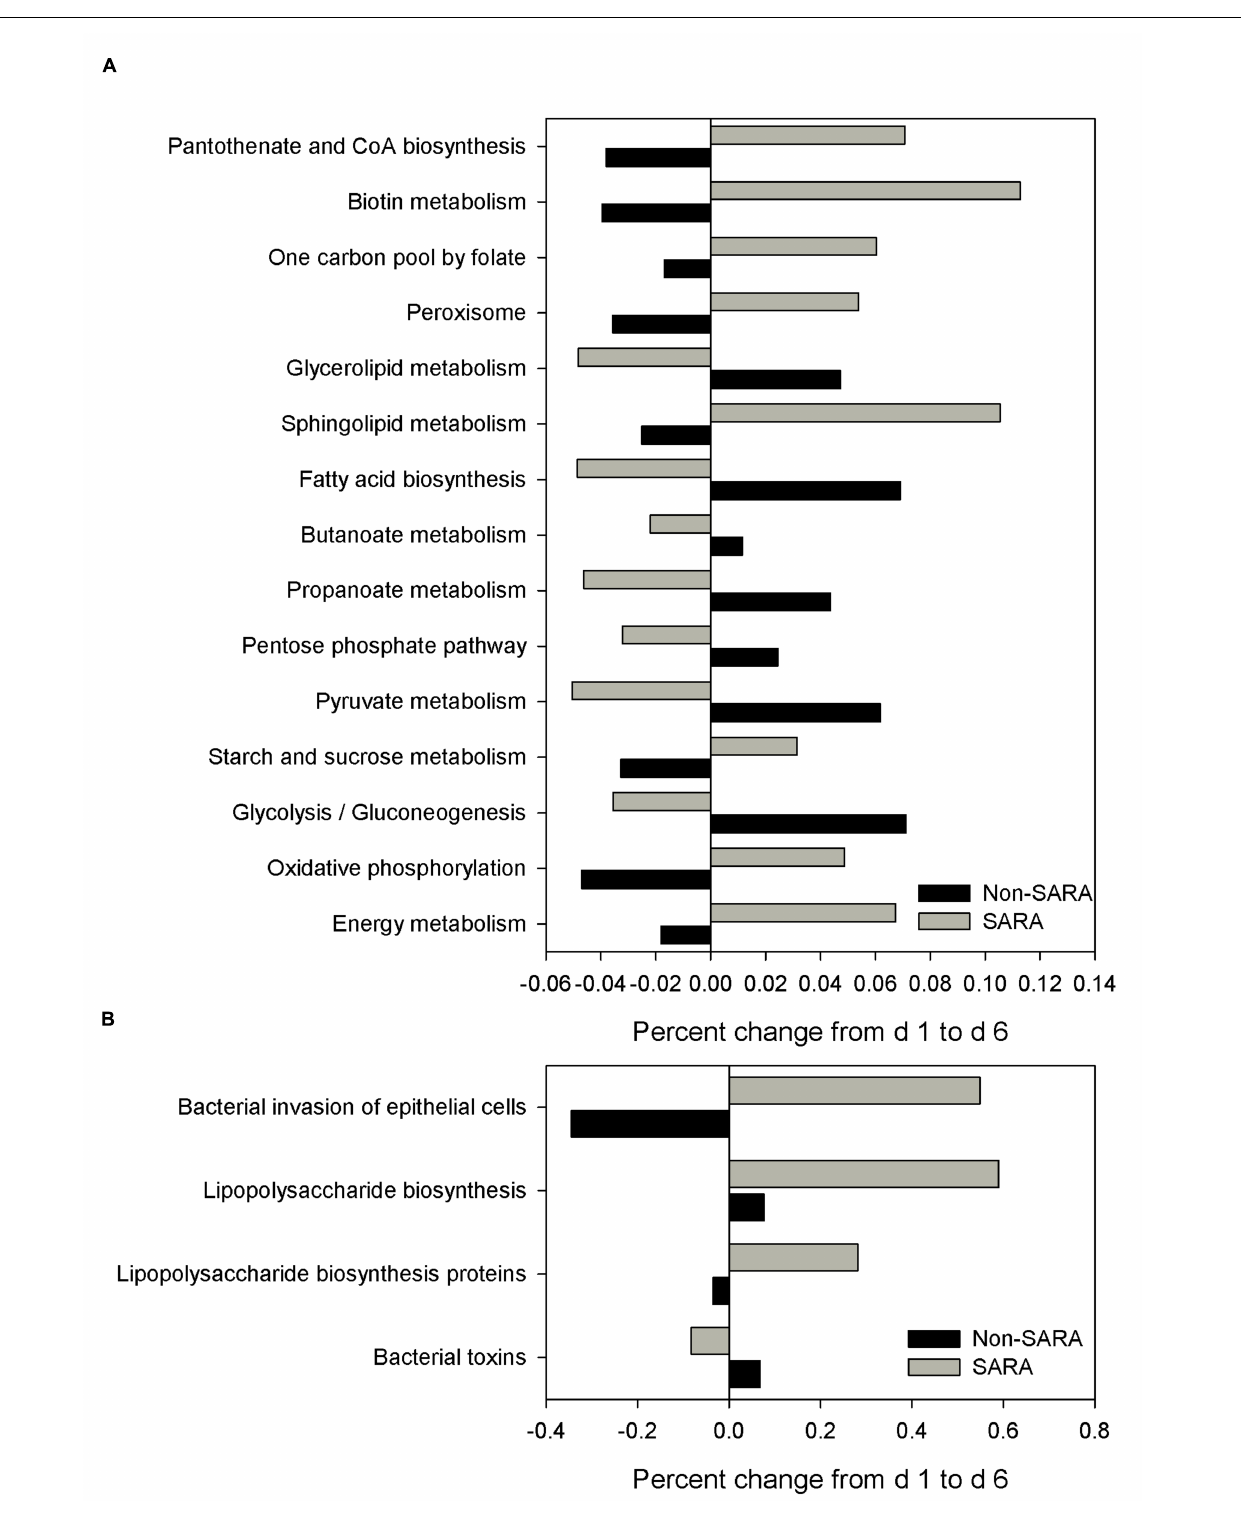
FIGURE 5 | Effect of SARA induction on the predicted metagenome pathways related to energy metabolism (A) and epithelial barrier function (B) in the solid fraction. Values represent the percentage change in expression of a given pathway from day 1 to day 6. Positive values indicate an increased representation on day 6 compared with day 1 of a given pathway in the predicted metagenome, while negative values describe a percent decrease on day 6 of a predicted pathway.